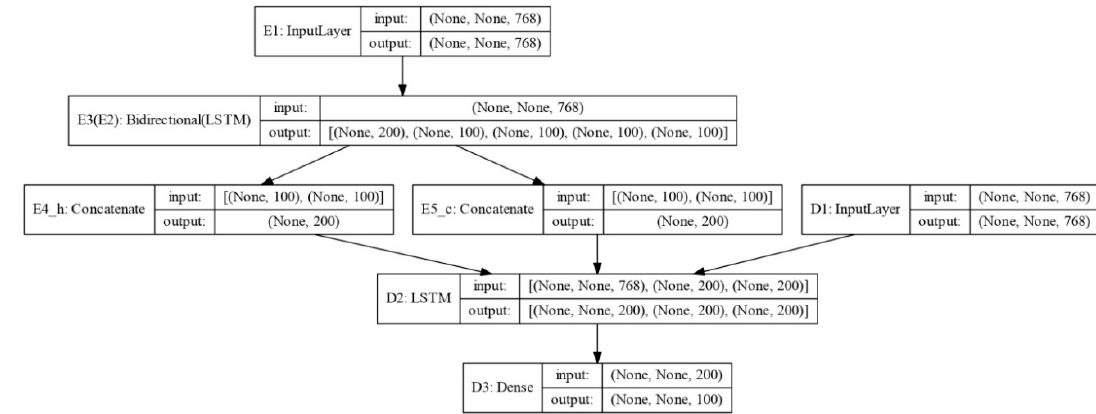
Figure 4. One-layer bidirectional LSTM (BiLSTM) encoder and one-layer LSTM decoder (abbreviated as BiLSTM encoder and LSTM decoder). E1, E2, E3, E4_h, E4_c represent the encoder; D1, D2, D3 represent the decoder.